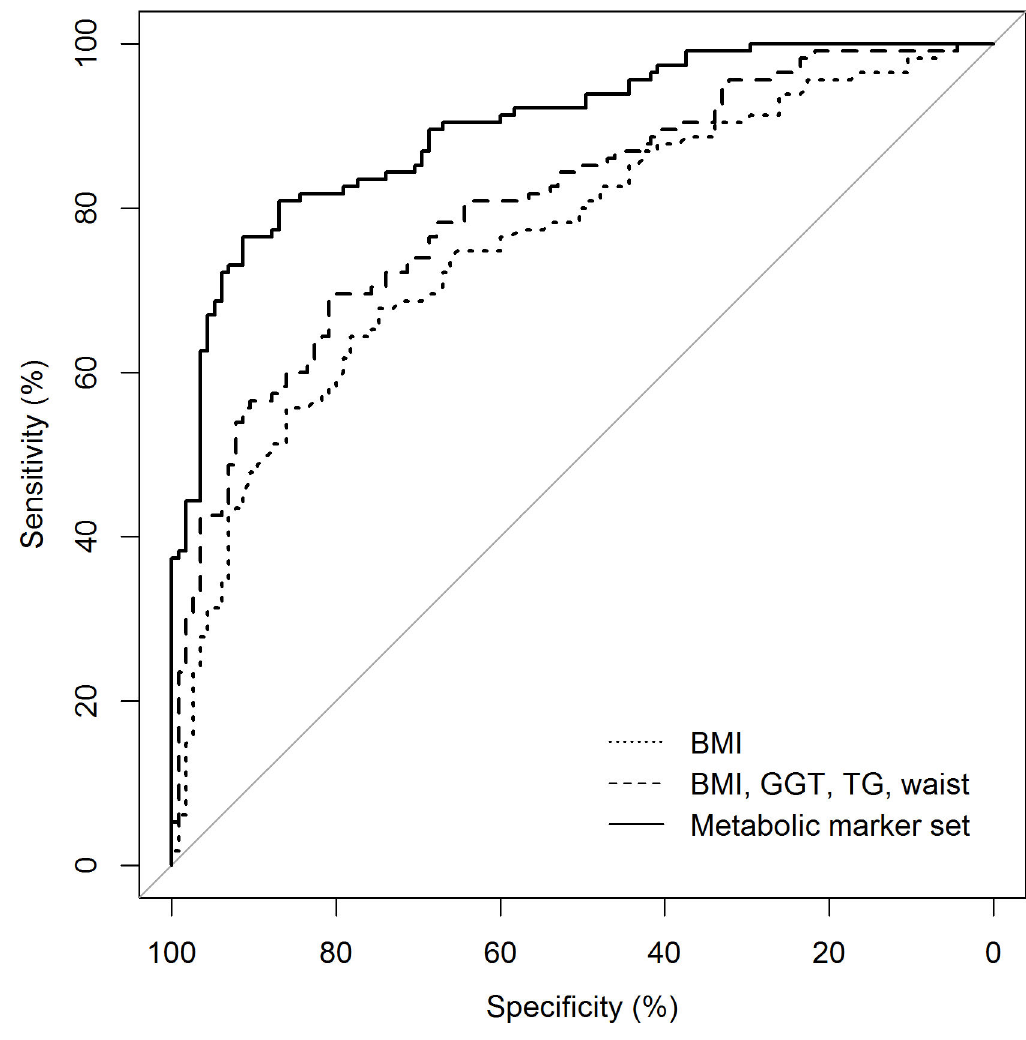
Figure 1. Comparison of the area under ROC curve (AUC) of three diagnostic models based upon 1: BMI; 2: BMI, GGT, TG, waist or 3: metabolic marker set. ROC statistics were based upon logistic regression analysis of 115 FLD patients and 115 controls. Compared to model 1 (AUC: 0.7609), AUC was significantly higher in both, model 2 (AUC: 0.8060, p=0.021) and model 3 (AUC: 0.8993, p=6.7×10 -6 ). A significant increase was also noted from model 2 to 3 (p=4.2×10 -4 ). doi: